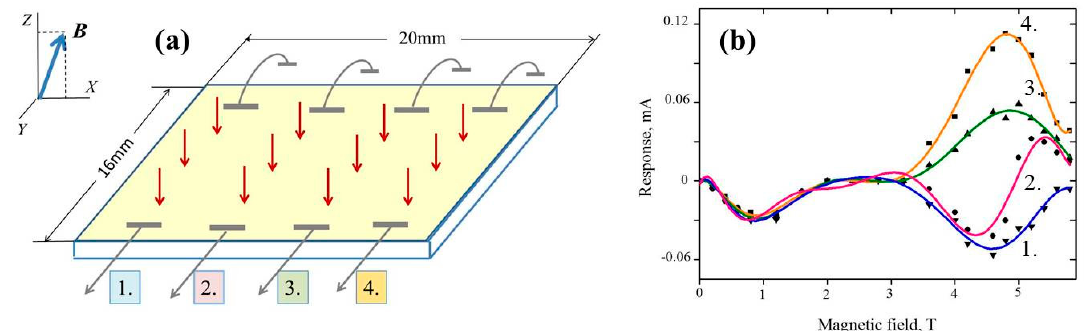
Figure 3. Evidence for a spontaneous quantum ordering throughout the whole system. ( a ) Sketch of the experiment. All sample area is exposed to the spatially-homogeneous laser radiation. Light-induced electric responses are detected through four contact pairs shifted from each other along the X -axis. ( b ) The outcome of the experiment. Solid lines are a guide for the eyes. Curves are numbered in accordance with the numbering of contact pairs.